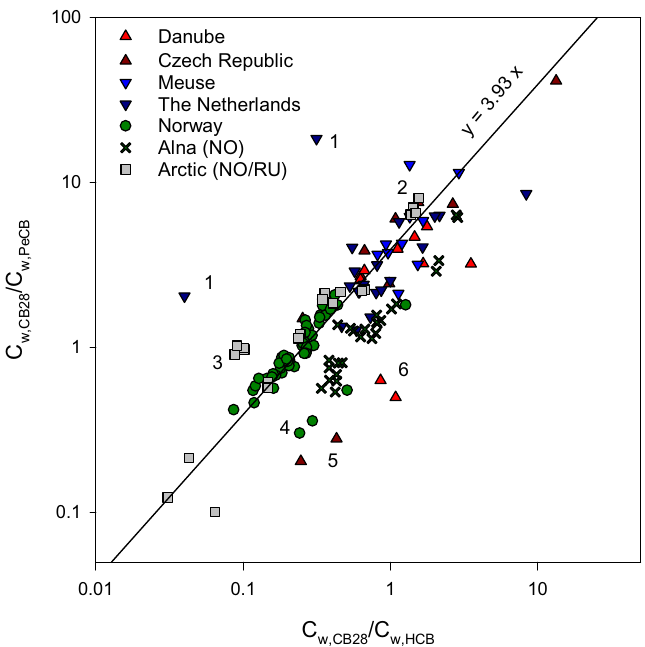
Figure 2. Benchmarking of freely dissolved concentrations of CB28 with those estimated for HCB and PeCB for all freshwater sampling sites. Note that every datapoint is plotted on the graph. Sites closest to the top right corner exhibit highest CB28 concentrations while those closest to the bottom left corner indicate lowest CB28 concentrations. Datapoints deviating from the reference diagonal line indicate either a PeCB contamination (towards the top left corner) or an HCB contamination (towards the bottom right corner). 1: Canals in The Netherlands with HCB contamination; 2: PCB contamination in the Pasvik river; 3: HCB contamination of the Pechenga river; 4 and 5: Low C w-HCB /C w-PeCB for the Rivers Alna and Borgebekken in Norway and Morava River in the Czech Republic; 6: PeCB contamination in the Danube